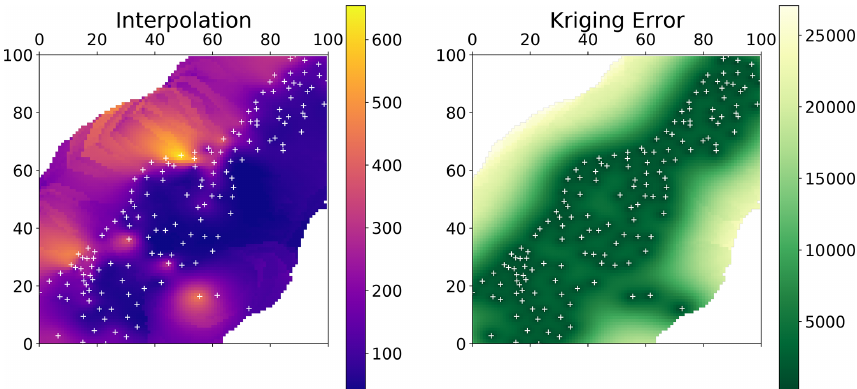
Figure A2. Ordinary kriging application using the theoretical variogram model shown in Fig. A1. The kriging procedure estimated the lead concentration on a 100 × 100 grid.